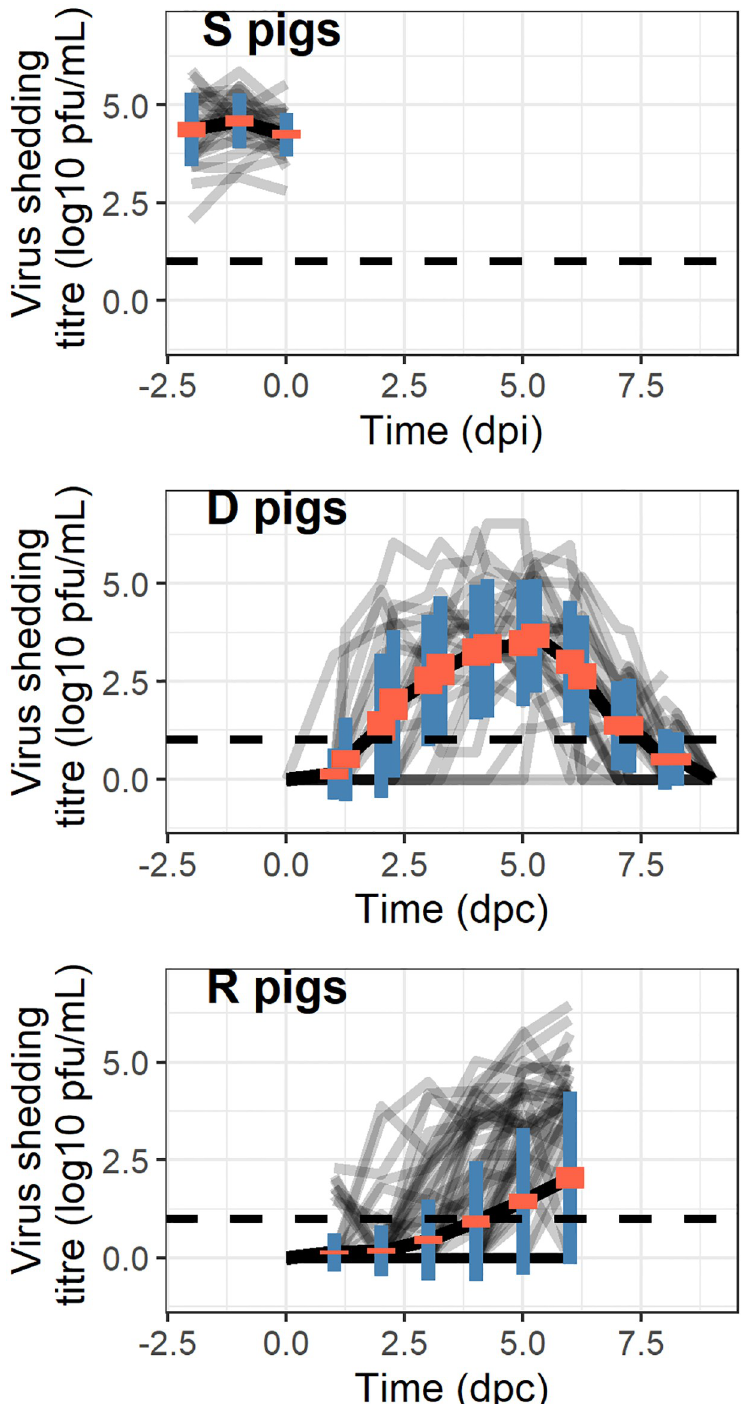
Fig 2. Individual viral kinetics for seeder pigs (upper left panel), donor pigs (lower left panel) and recipient pigs (right panel). Each grey line represents an individual pig. The black line represents the mean viral shedding titre at each sample time. The error bars represent the standard error of the mean. For the seeder pigs time represents the day post inoculation (dpi) whereas for the donors and recipients time represents day post contact (dpc) with the seeder and donor, respectively. For the recipient pigs, the color of the lines represents the day of contact between the donor and the recipient (since the infection of the donor). The dashed line represents the limit of detection.